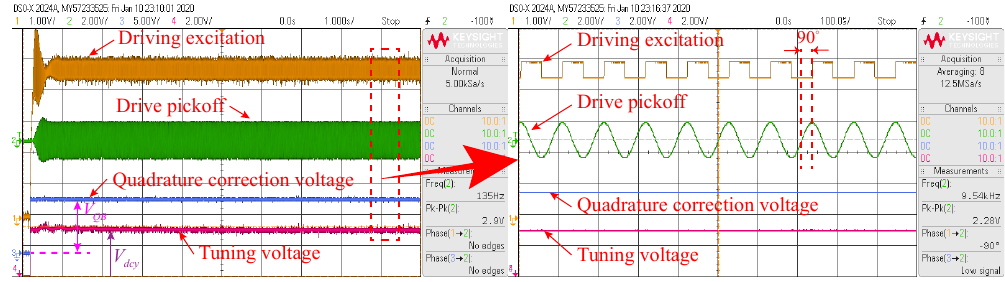
Figure 11. The waveforms of the mode-matching system startup process at room temperature.